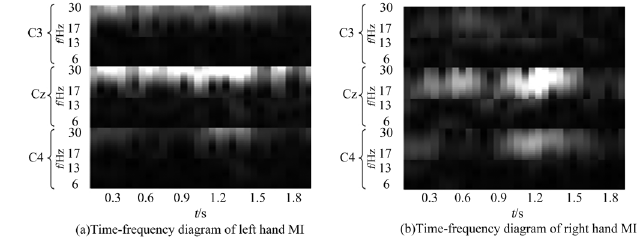
Table 3. Comparison of